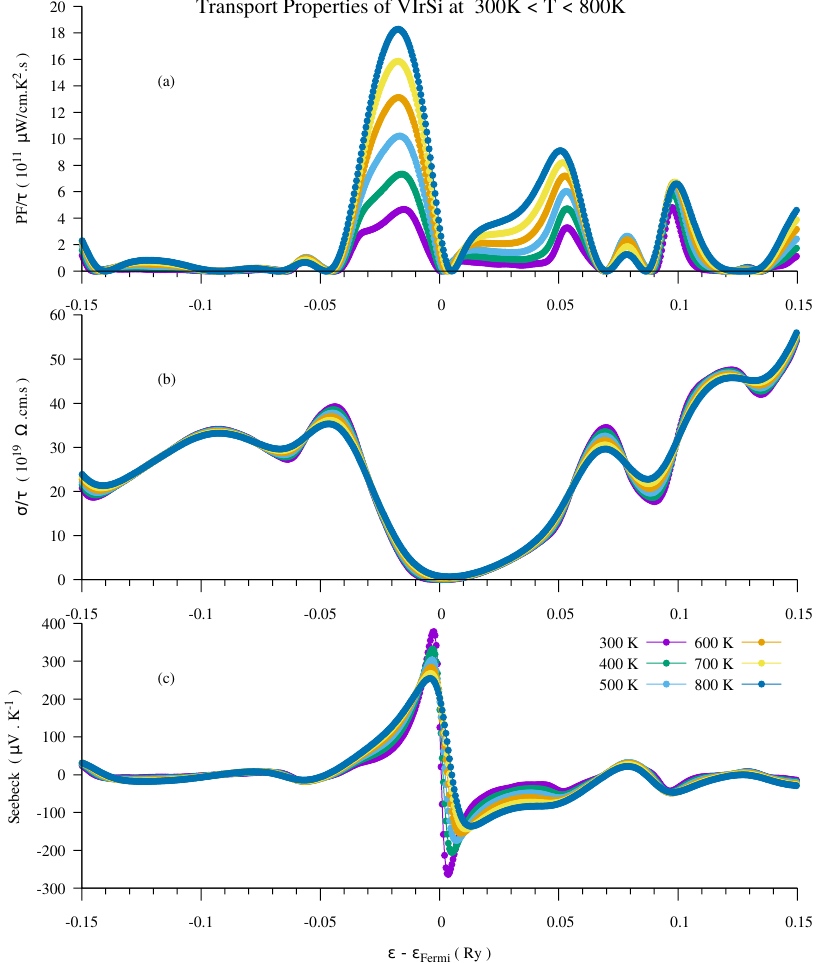
Figure 4. ( a ) Power factor, ( b ) Electrical conductivity, and ( c ) Seebeck coefficient of VIrSi half- Heusler